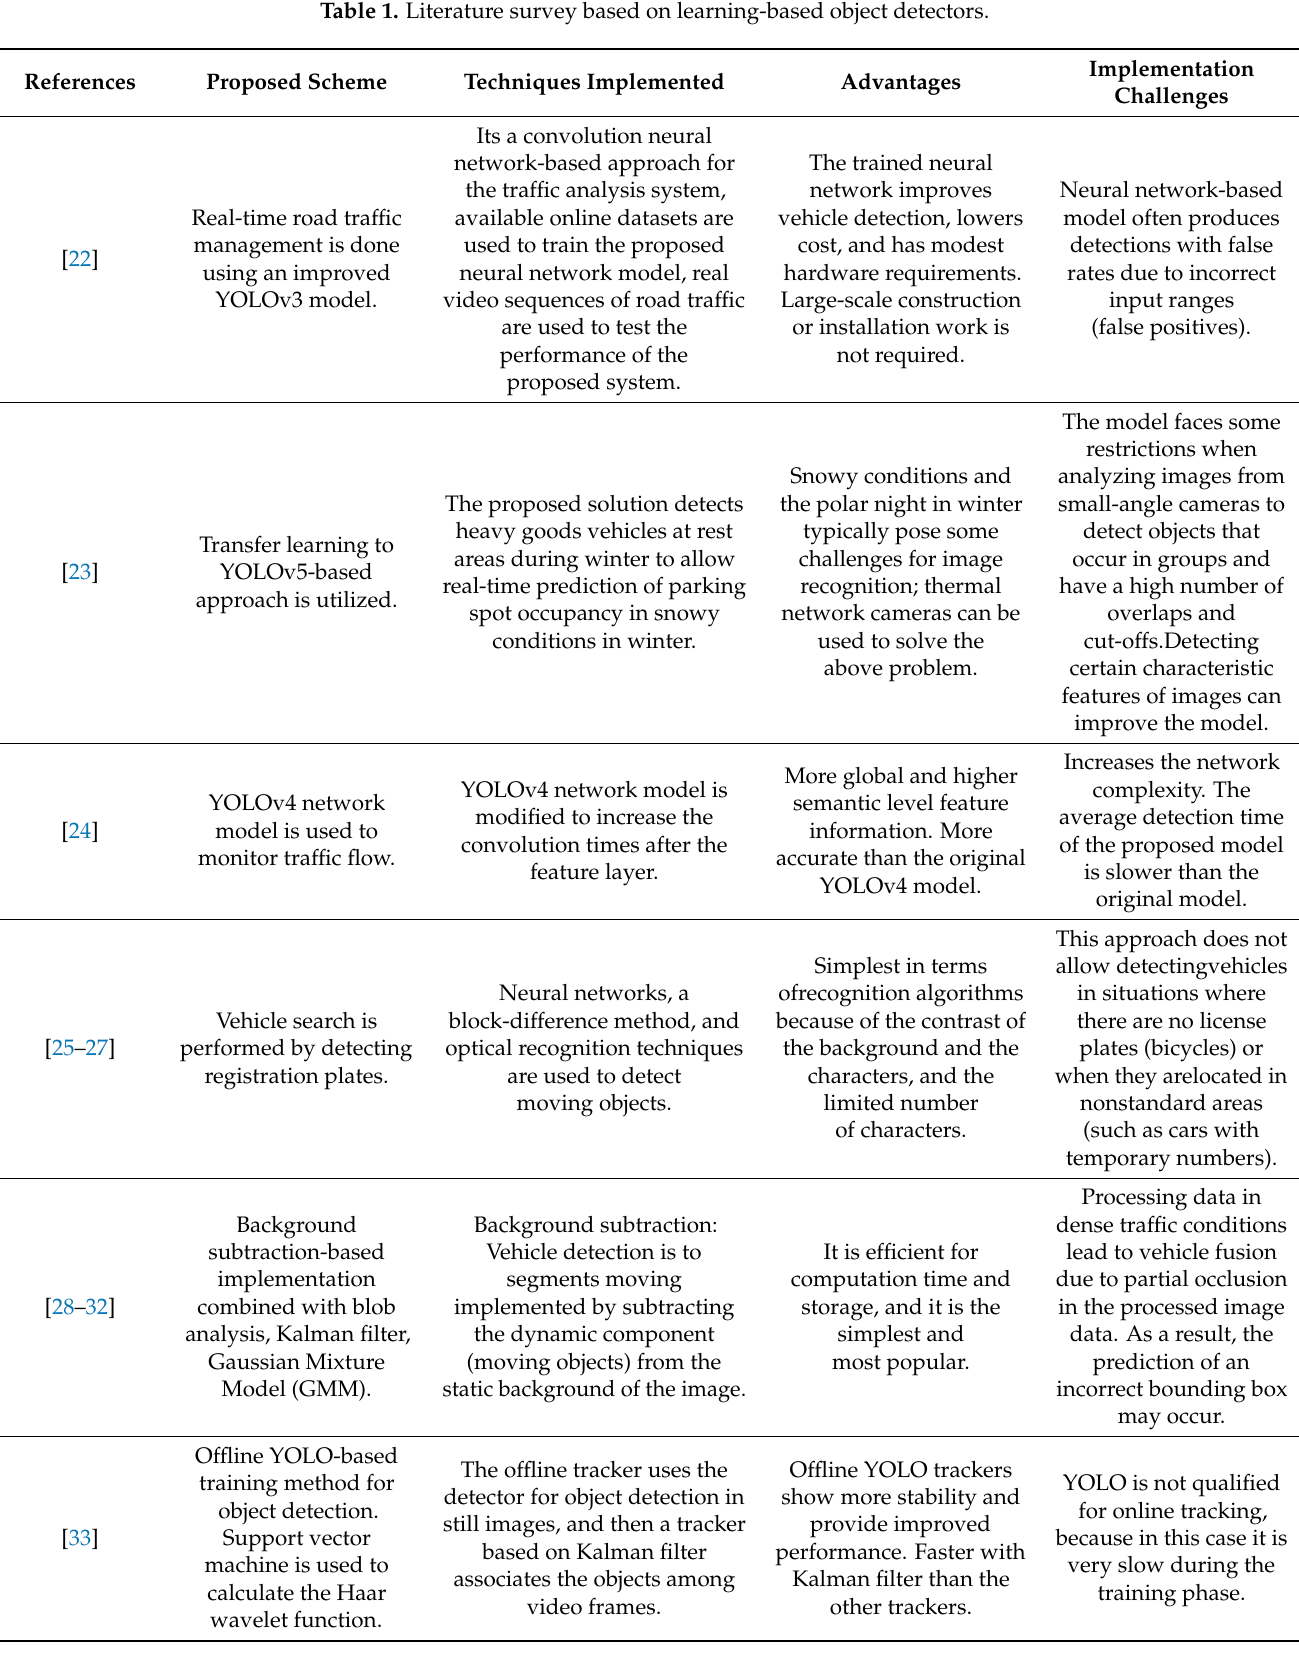
Table 1. Literature survey based on learning-based object